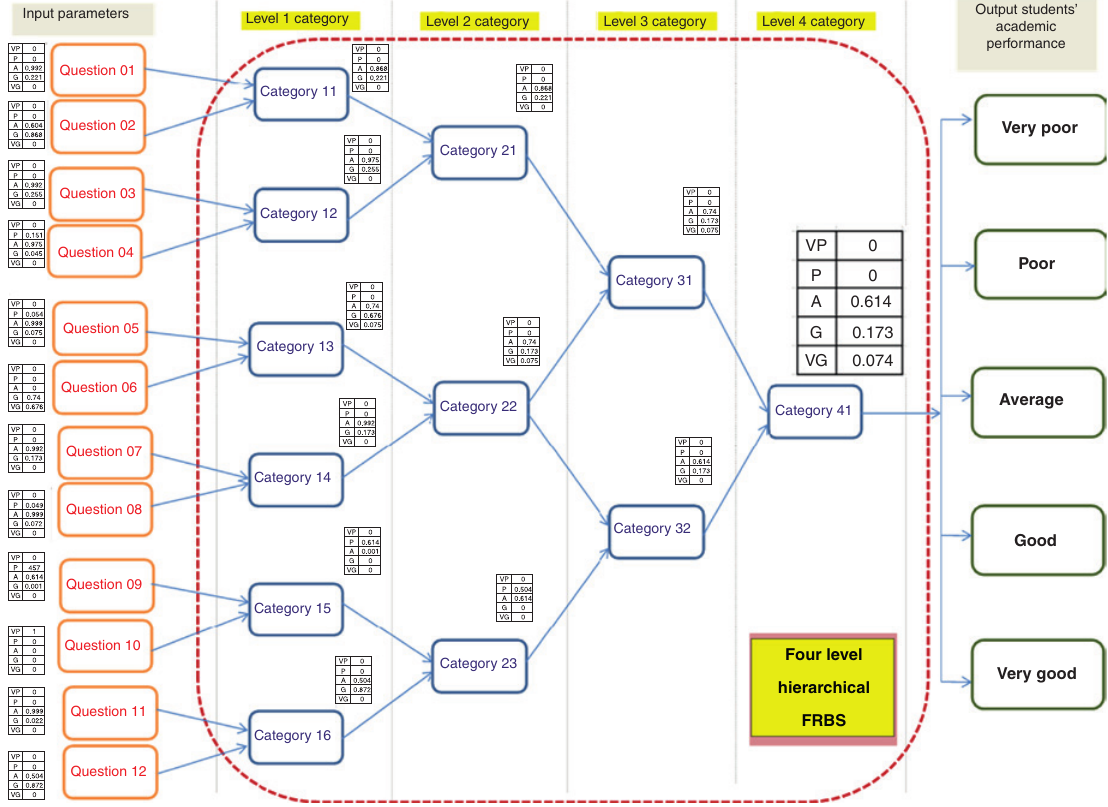
Figure 1: Four-Level Hierarchical Multiexpert FRBS with DM Computations in the Performance Evaluation of Student